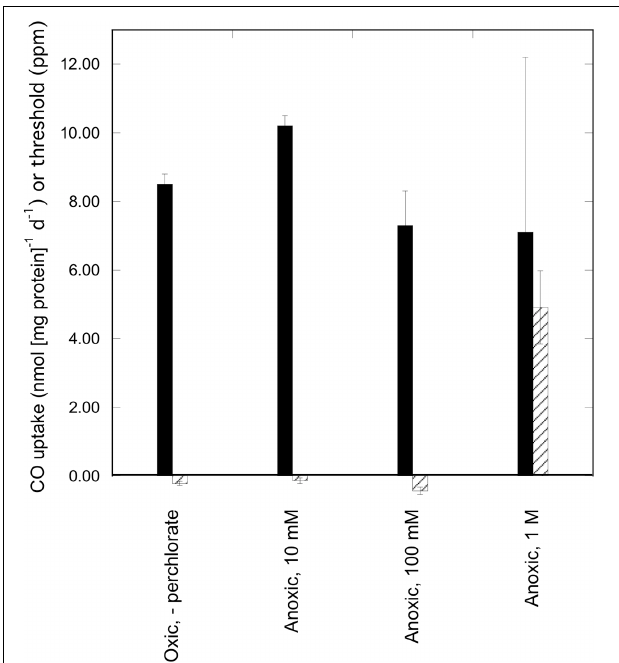
FIGURE 3 | Perchlorate tolerance by Haloarcula sp. PCN7 under anoxic conditions. CO uptake rates (nmol CO [mg protein] − 1 d − 1 ; solid bars) and uptake thresholds (ppm; cross-hatched bars) for isolate Haloarcula sp. PCN7 during aerobic and anaerobic incubations in 3.8 M NaCl with varied concentrations of perchlorate; values are means of triplicate cell suspensions ± 1 standard error; negative threshold values were not significantly different than